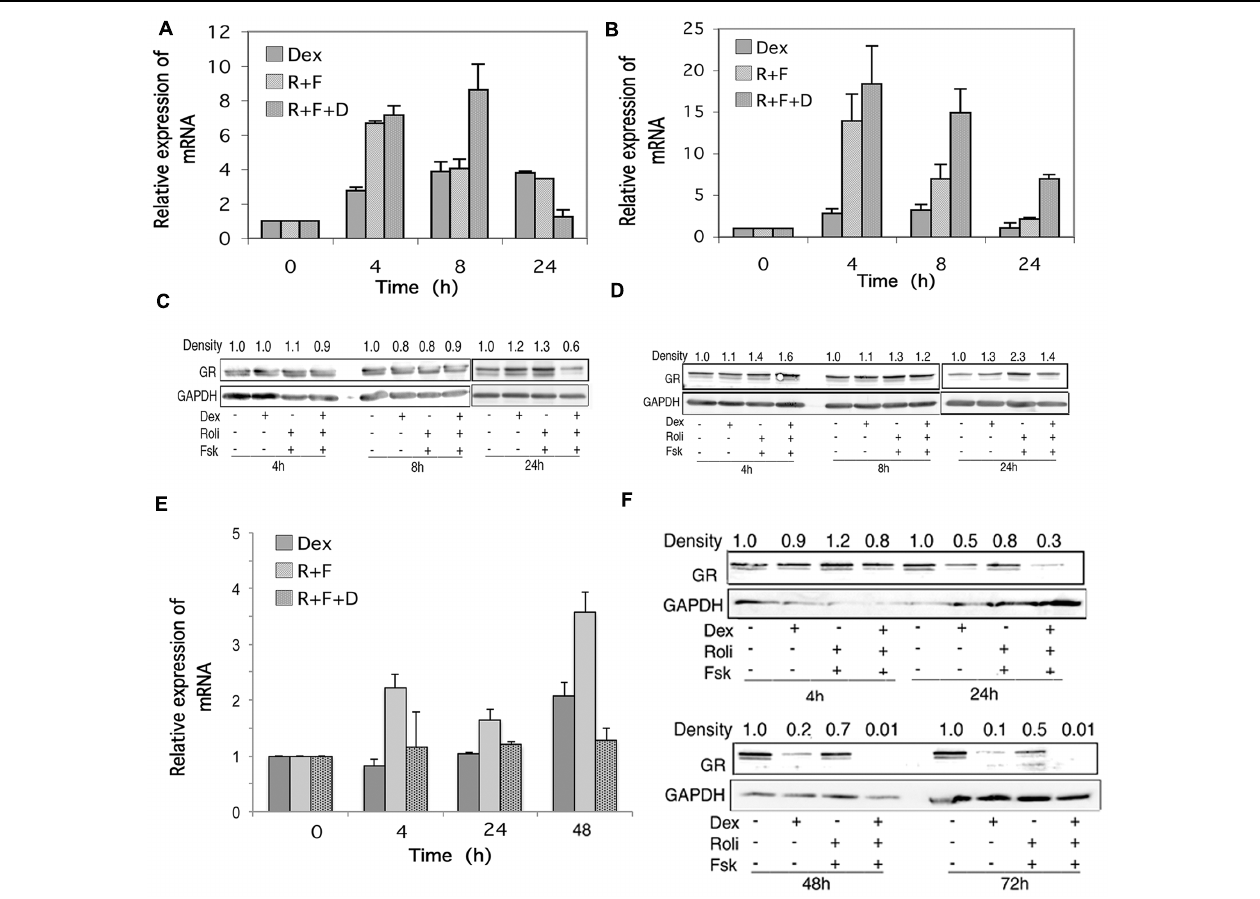
FIGURE 3 | Glucocorticoid receptor (GR) expression in CEM and MM.1 cells. (A,B,E) Quantitative real-time PCR analysis of GR mRNA expression in CEM-S2 (A) , CEM-R8 (B) , and MM.1S (E) cells, following treatment with 1 µ M dexamethasone (Dex), 10 µ M rolipram plus 10 µ M forskolin (R + F), or 1 µ M dexamethasone plus 10 µ M rolipram plus 10 µ M forskolin (R + F + D) at different times as indicated. Data represent the mean ± SD of at least two independent experiments assayed in triplicate, shown as fold change relative to control. (C,D,F) Western blot analysis of GR protein expression in CEM-S2 (C) , CEM-R8 (D) , and MM.1S (F) cells following treatment at different times with dexamethasone and/or rolipram and forskolin as indicated. Equal amounts of protein (20 µ g) from whole cell lysates were added per lane. Data shown represents one of at least two independent experiments with similar results. The numbers at the top of the Western blot images represent the GR band densities following different treatments relative to control, normalized based on the density of the GAPDH housekeeping protein, calculated as described in Section “Materials and